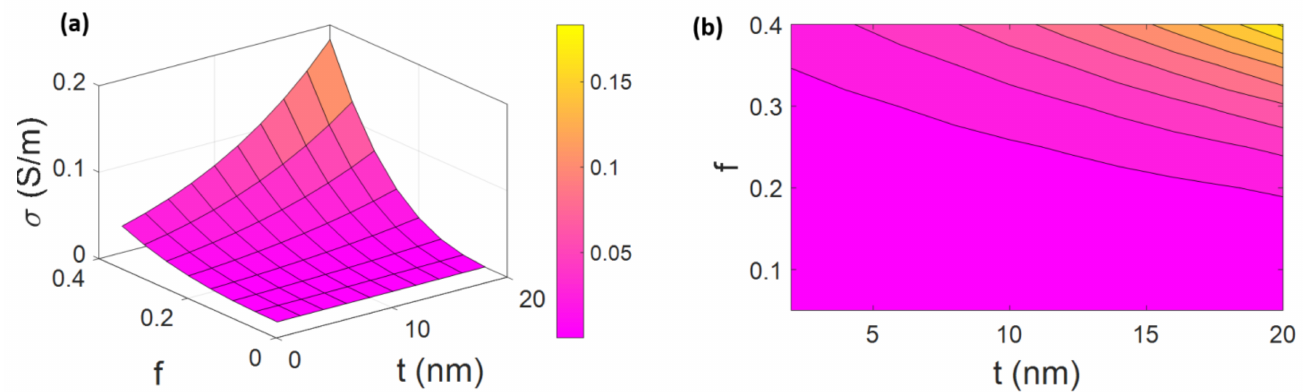
Figure 7. The relations of “ t “ and “ f “ with the conductivity by ( a ) 3D and ( b ) 2D illustrations.